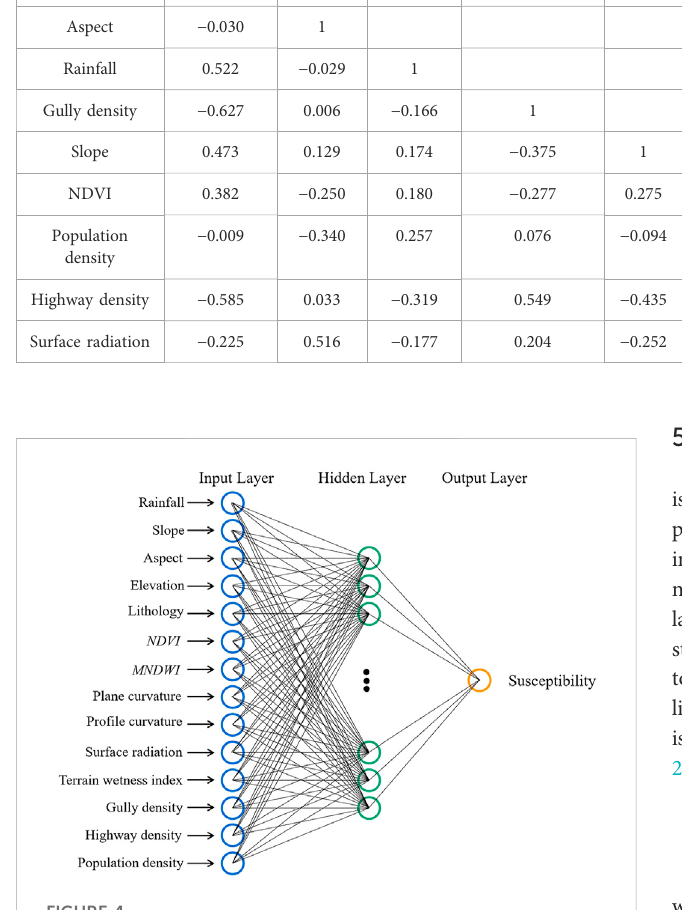
FIGURE 4 Multilayerperceptronstructurediagramof fl ash fl oodsusceptibility